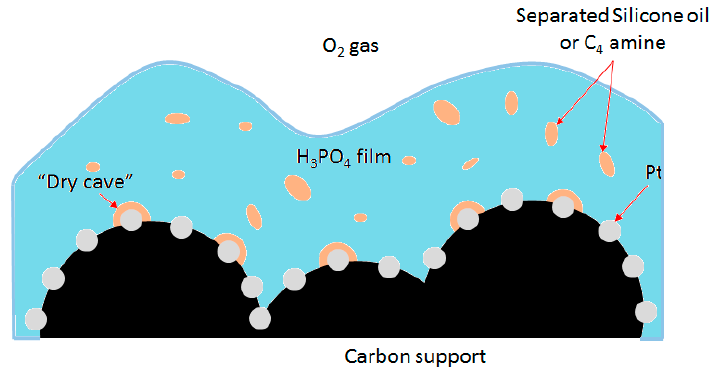
Figure 4. Sketch of electrolyte coated catalyst. The phosphoric acid film contains a segregated additive which provides higher oxygen permeability and a physically adsorbed layer on the Pt surface to block phosphate